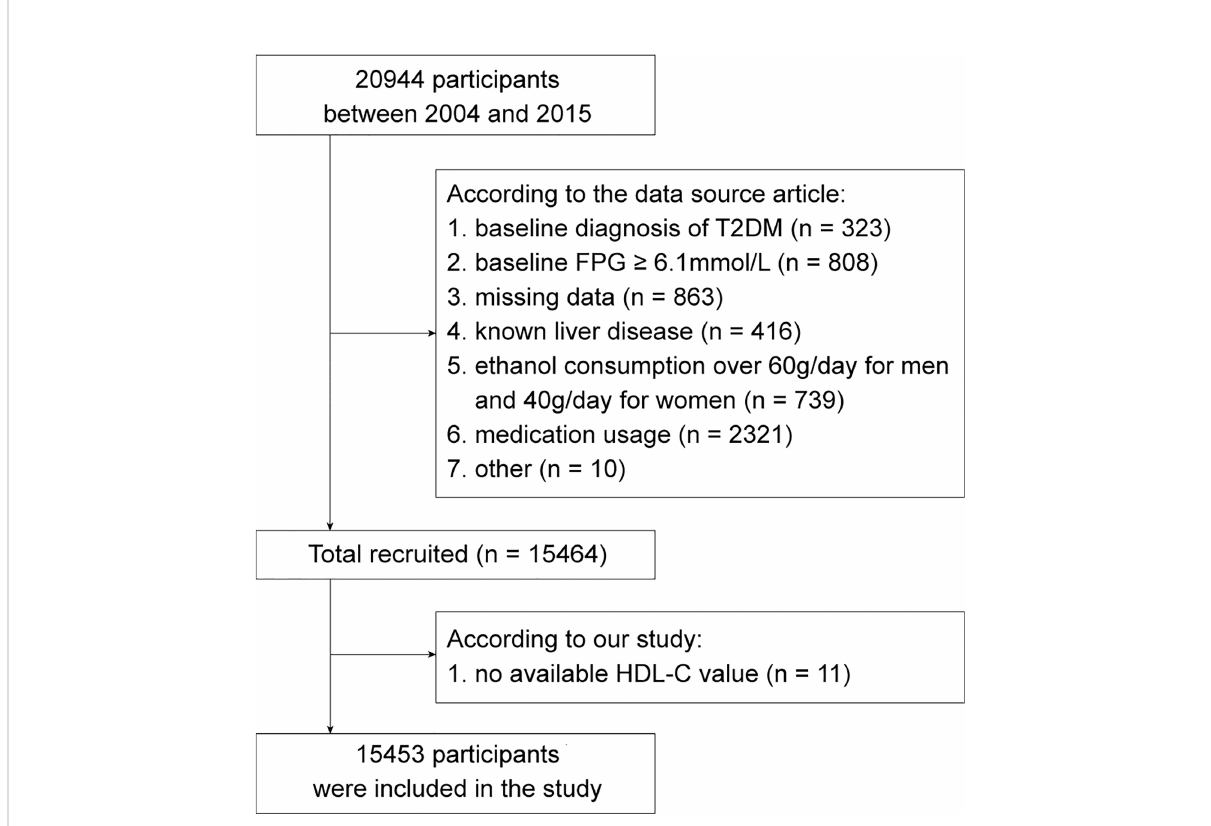
FIGURE 1 The fl ow chart of study participants selection. FPG, fasting plasma glucose; HDL-C, high-density lipoprotein cholesterol. T2DM, type 2 diabetes